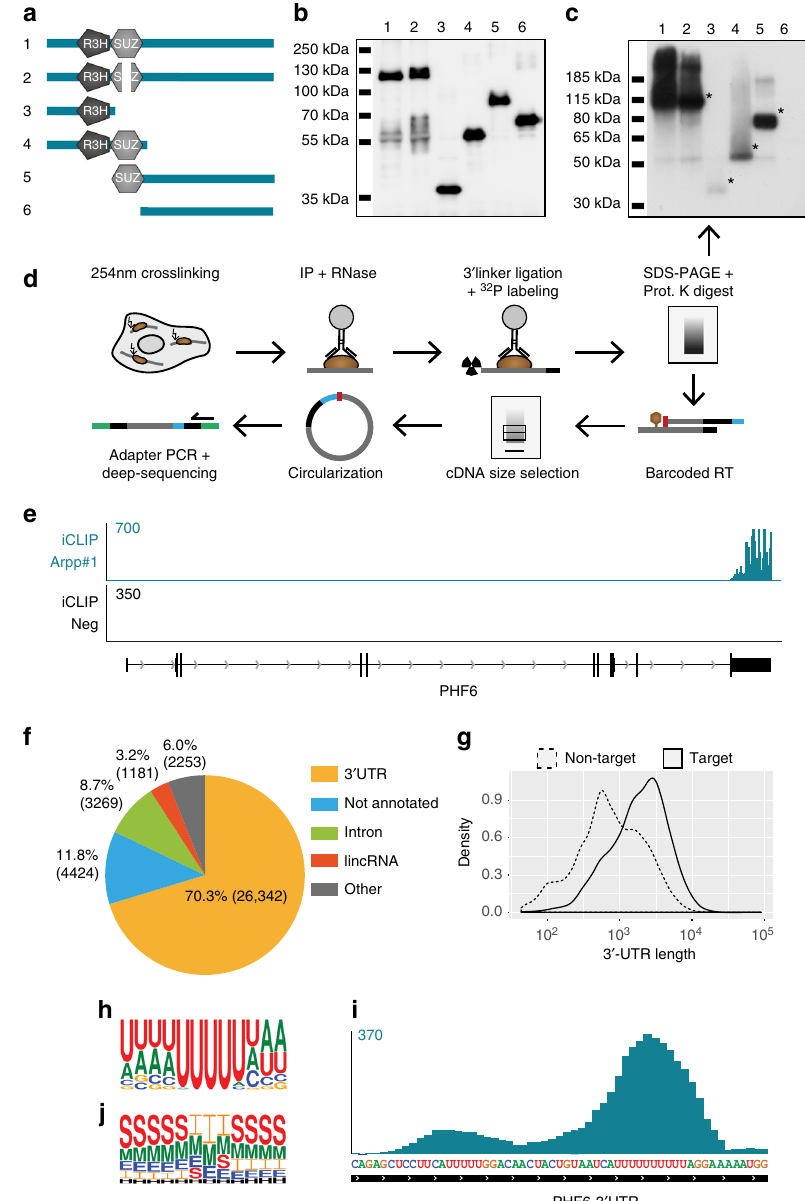
Fig. 4 iCLIP identi fi es the ARPP21 – RNA interactome. a ARPP21 deletion constructs used in UV-crosslinking experiments to assess their RNA-binding potential. Construct 2 conforms to a splice variant that lacks a part of the SUZ domain. b SDS-PAGE with FLAG immunoblot con fi rms immunoprecipitation of all ARPP21 variants, lane designations refer to constructs depicted in a . c Autoradiogramm of crosslinked and 32 P-labeled ARPP21 – RNA complexes separated by NuPAGE, lane designations as in a and b . All variants harboring at least one of the predicted RNA-binding domains exhibit RNA-binding ability (*), the C-terminal only Construct 6 yielded no signal. d Schematic overview of the iCLIP procedure performed with iARPP21 cells. Unique barcodes (blue) introduced during the reverse transcription allow for multiplexing iCLIP samples. Due to the circularization step, truncated cDNAs are captured and the position of protein – RNA crosslinking (red) can be accurately assessed. Green: deep-sequencing adapters. e Representative ARPP21 iCLIP coverage at the Phf6 locus shows speci fi city for the 3 ′ UTR. The negative control iCLIP from cells not expressing ARPP21 shows negligible background. Numerical scale on left refers to unique crosslinking events (CEs). f Genome-wide characterization of unique CEs for ARPP21 by RNA type. g 3 ′ UTRs of ARPP21 targets are longer compared to non-ARPP21 target transcripts. Median 3 ′ UTR length of ARPP21 target mRNA: 1.99 kb. Median 3 ′ UTR length of ARPP21-unbound mRNA: 0.72 kb. h Nucleotide representation fl anking the crosslink site as determined by GraphProt identi fi es a uridine-rich motif. i ARPP21 iCLIP signals are enriched at uridine-rich sequences. A representative peak from the Phf6 3 ′ UTR is shown; the numerical scale at left refers to unique CEs. j Secondary structure analysis of the ARPP21 interaction motif by GraphProt. The center of the motif containing the crosslinked nucleotide is largely devoid of predicted stems. E external loop, H hairpin, I internal loop, M multi loop, S